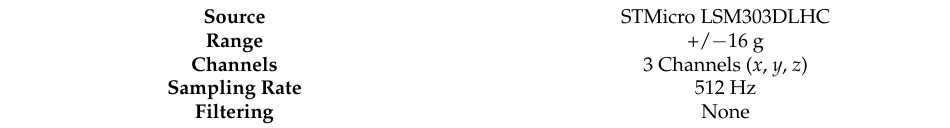
Table A1. Accelerometer specification.